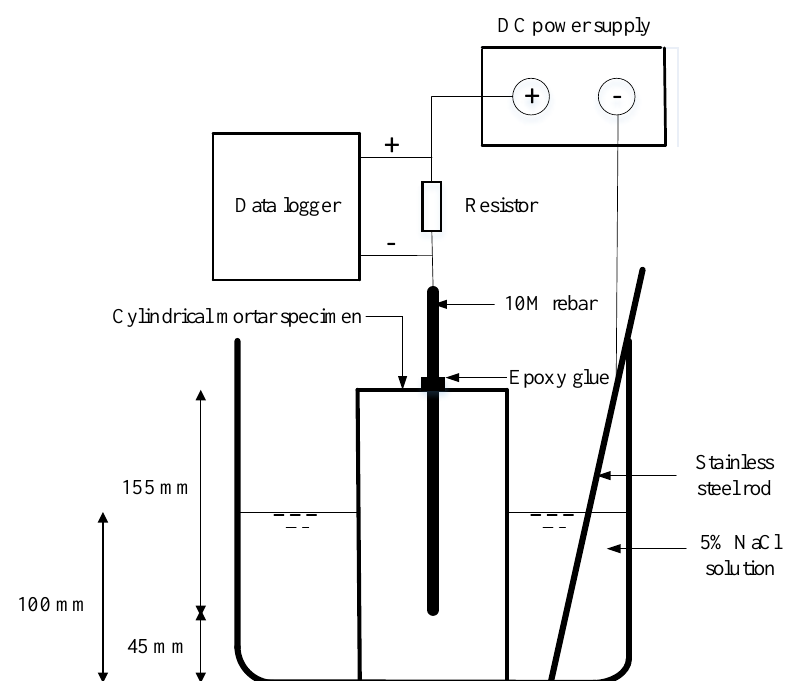
Figure 1. Accelerated corrosion test schematic.